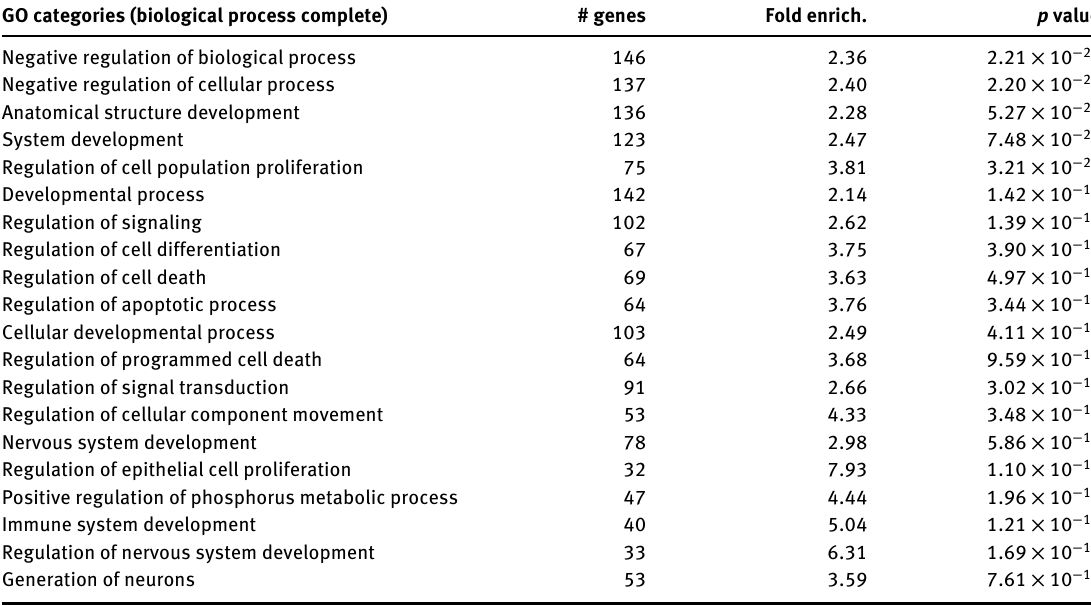
Table 2: Categories of gene ontologies for glioblastoma genes according to PANTHER (biological process). GO categories (biological process complete) # genes Fold enrich. p